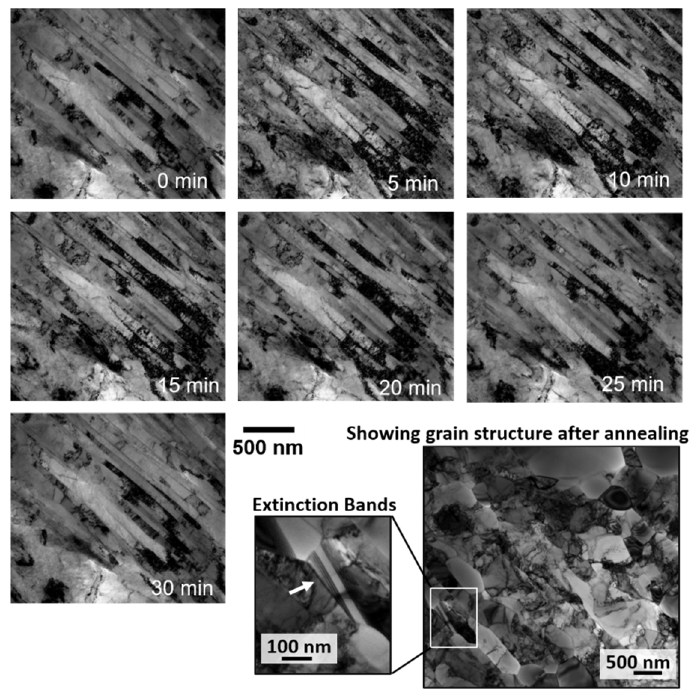
Figure 1. TEM micrographs of in-situ annealing of NC Cu from 0 to 700 °C in 30 min. The bottom right image shows a lower magnification image of a grain structure (after annealing) in a different thin area of the sample with some non-equilibrium grains marked by extinction bands.